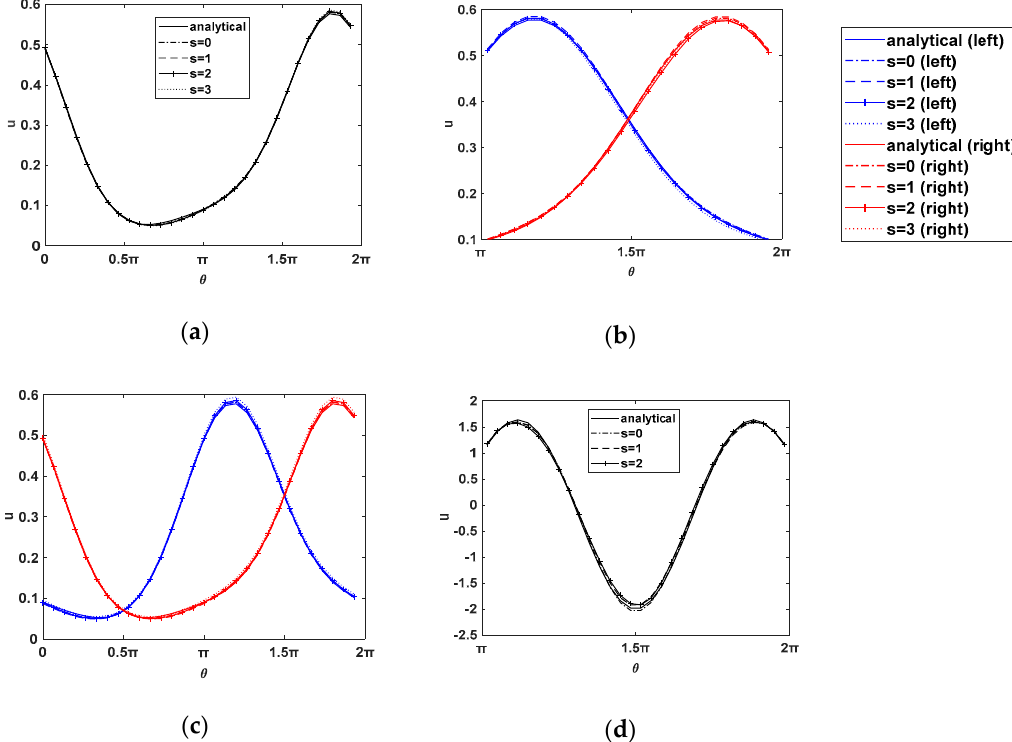
Figure 13. Comparison of numerical solutions along missing boundary obtained by various s : ( a ) half unknown inner boundary; ( b ) two half unknown inner boundaries; ( c ) unknown inner boundaries; ( d ) half unknown outer boundary.